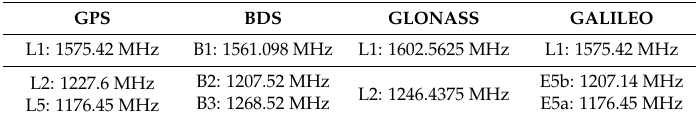
Table 4. Signal frequencies for the four main GNSS systems.